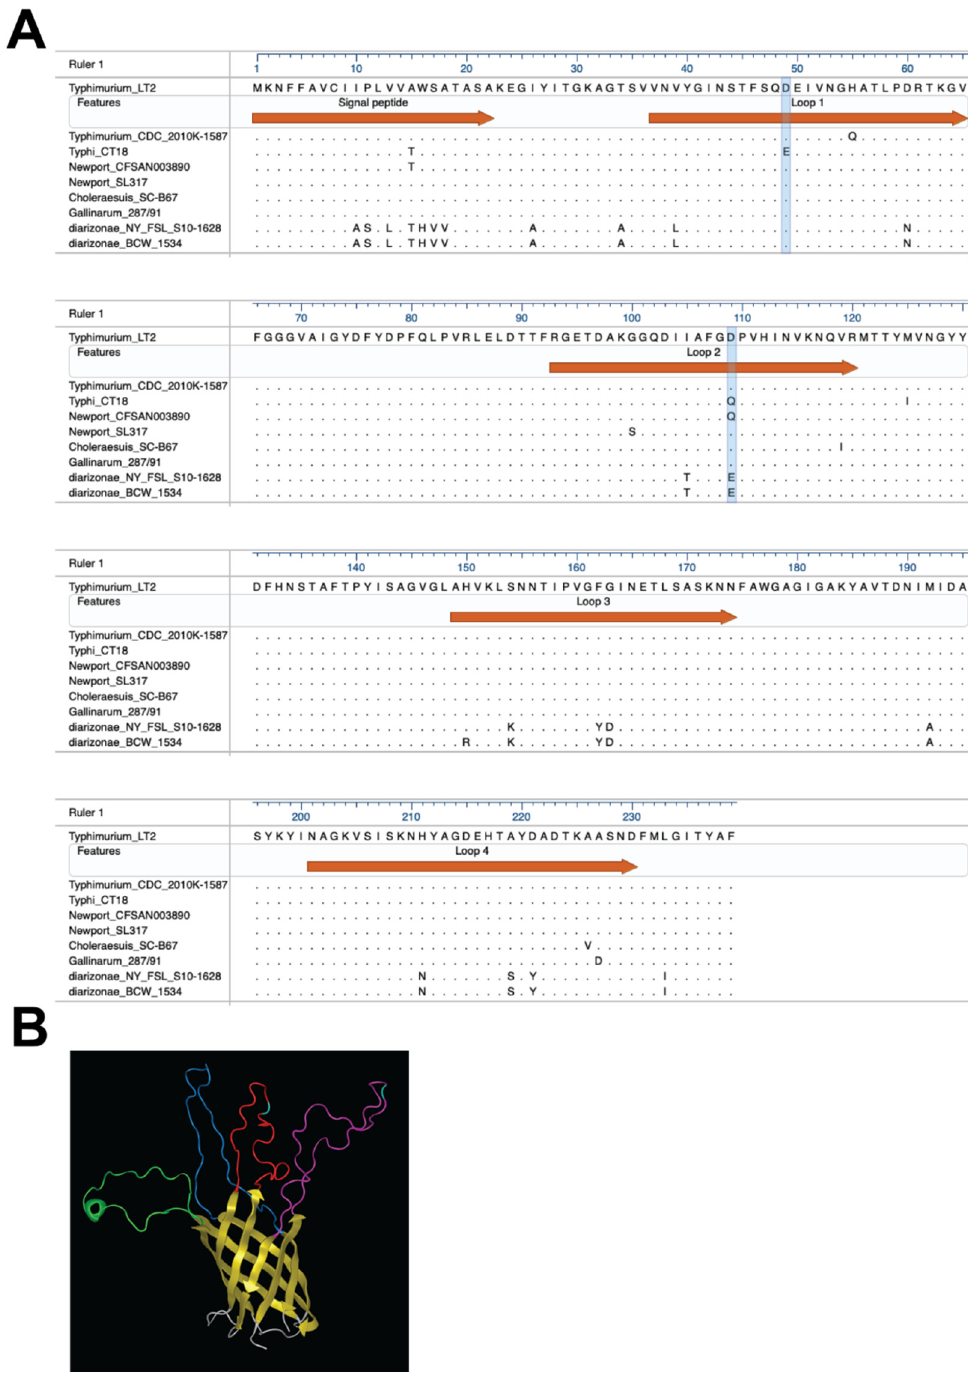
Figure 1. PagN sequences and predicted structure. ( A ) Alignment of PagN alleles from different Salmonella strains (Table S3) [10] each representing N strains from one or more serovars, or clusters within serovars or subspecies with the same sequence in the surface loops of mature PagN; S. Typhimurium_LT2 ( n = 68) with same sequence for S. Enteritidis ( n = 74), S. Pullorum ( n = 29), S. Dublin ( n = 74), and a cluster of Newport strains ( n = 25); S. Typhimurium_CDC_2010k-1587 ( n = 7); S. Typhi_CT18 ( n = 75); S. Newport_CFSAN003890 ( n = 23); S. Newport_SL317 ( n = 22); S. Choleraesuis_SC-B67( n = 74); S. Gallinarum 287/91( n = 23); S. diarizonae NY_FSL_S10-1628 ( n = 3) and S. diarizonae_ BCW_1534 ( n = 45). ( B ) S. Typhimurium mature PagN model predicted with I-TASSER. Color codes are for the membrane spanning beta-barrel (yellow), the periplasmic loops (grey), surface-exposed loop 1 (purple) with residue 49 (turquoise), loop 2 (red) with residue 109 (turquoise), loop 3 (green) and loop 4 (dark blue).